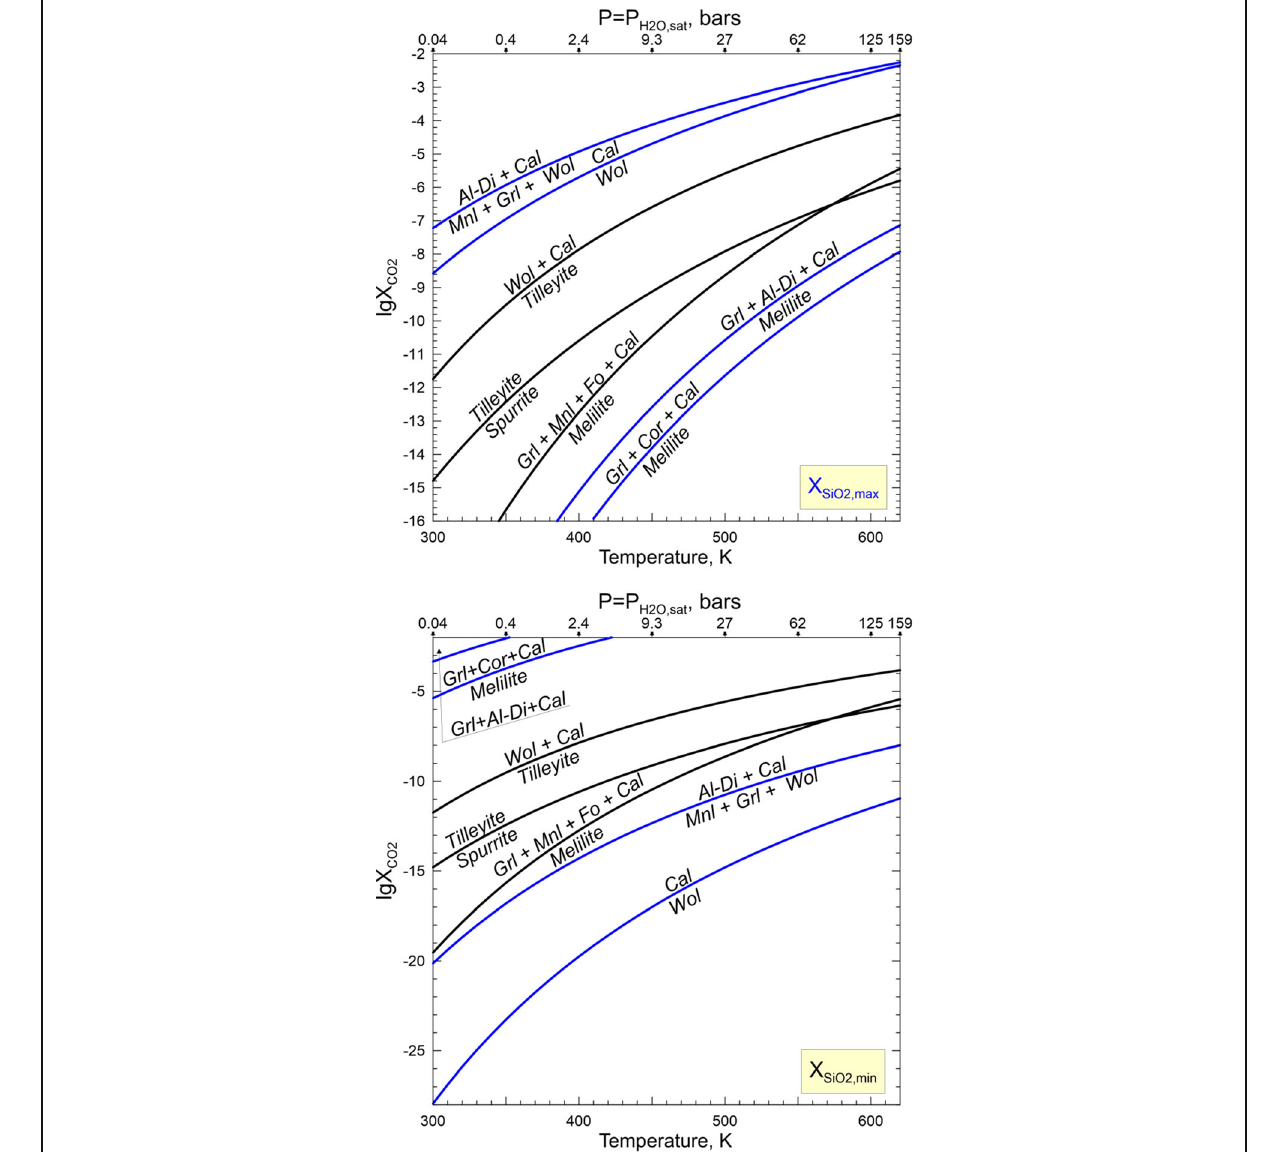
Fig. 17 Phase boundaries of reactions involving CO 2 (R16, R28, R29 - black lines) and aqueous SiO 2 (R6, R7, R14, R30 - blue lines) at maximal (X SiO2,max defined by R27 - top panel) and minimal (X SiO2,min defined by R5 - bottom panel) values of SiO 2